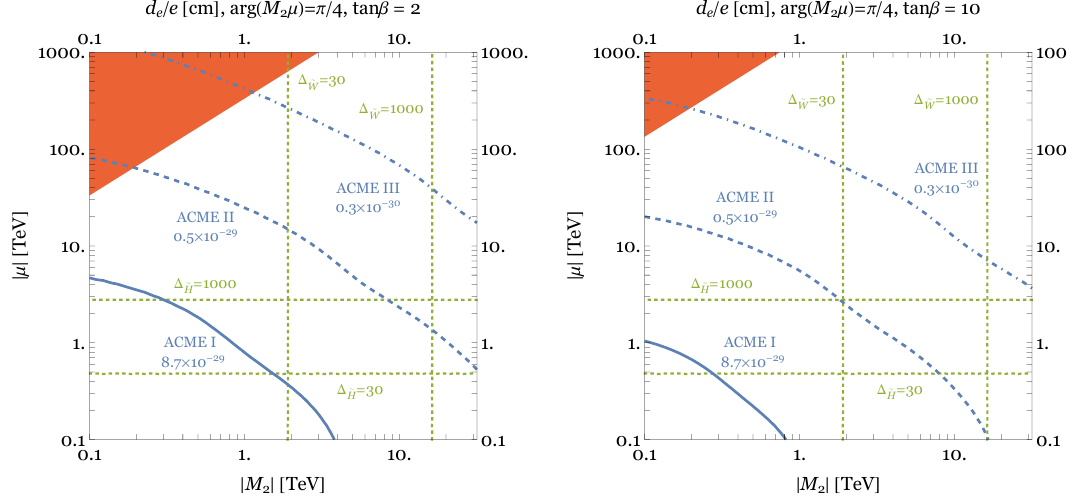
Figure 11 . Constraints on chargino parameter space from the ACME constraint (and future projections) on the electron EDM d e , in the limit when all particles except charginos and neutralinos are decoupled. Notice that masses are in TeV . In both (cid:12)gures the CP-violating phase is taken to be (cid:25)= 4. The left (cid:12)gure shows the case tan (cid:12) = 2 whereas the right (cid:12)gure shows tan (cid:12) = 10. Regions to the lower left of the blue curves are (or will be) probed by the ACME measurement. We have d e / sin 2 (cid:12) (cid:24) 1 = tan (cid:12) , so the constraints are weaker at large tan (cid:12) . Dotted green lines show contours of (cid:12)ne tuning arising from the e(cid:11)ects of the higgsino and wino masses on the Higgs potential at tree level and one loop, respectively. The dark orange shaded regions involve a tuning purely within the chargino sector (unrelated to electroweak naturalness) and so are disfavored. can be understood by (cid:12)rst integrating out the charginos at one loop to